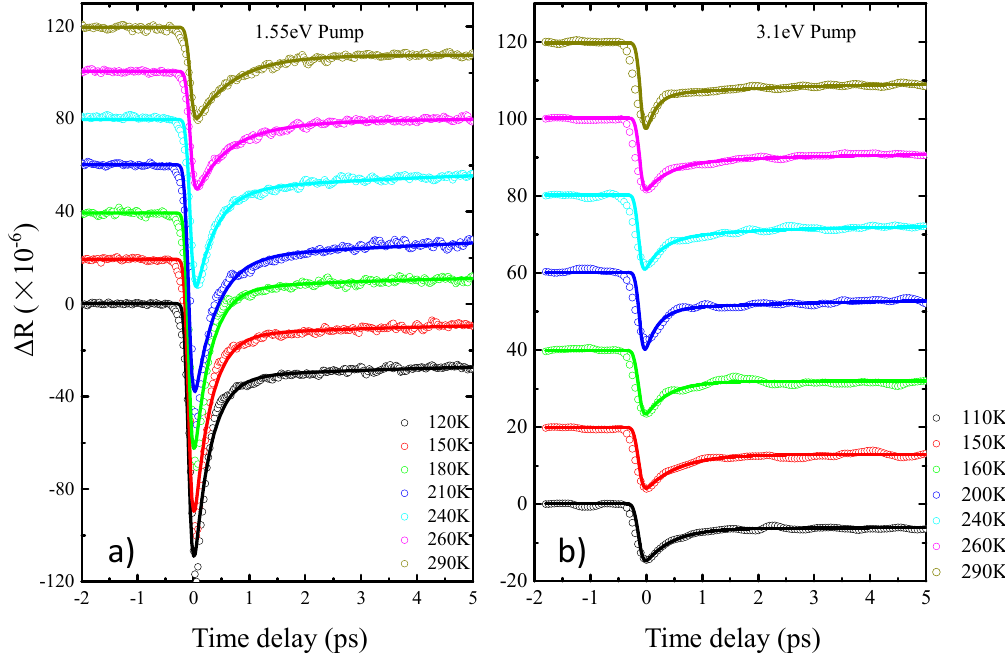
Figure 2. ( a ) The time resolved Δ R of Bi 2 FeMnO 6 film with a 1.55 eV pump and 1.55 eV probe setup. The vertical direction is shift with equal magnitude for clarity. ( b ) The time resolved Δ R of Bi 2 FeMnO 6 film with 3.1 eV pump and 1.55 eV probe setup, the vertical direction is shift with equal magnitude for clarity.